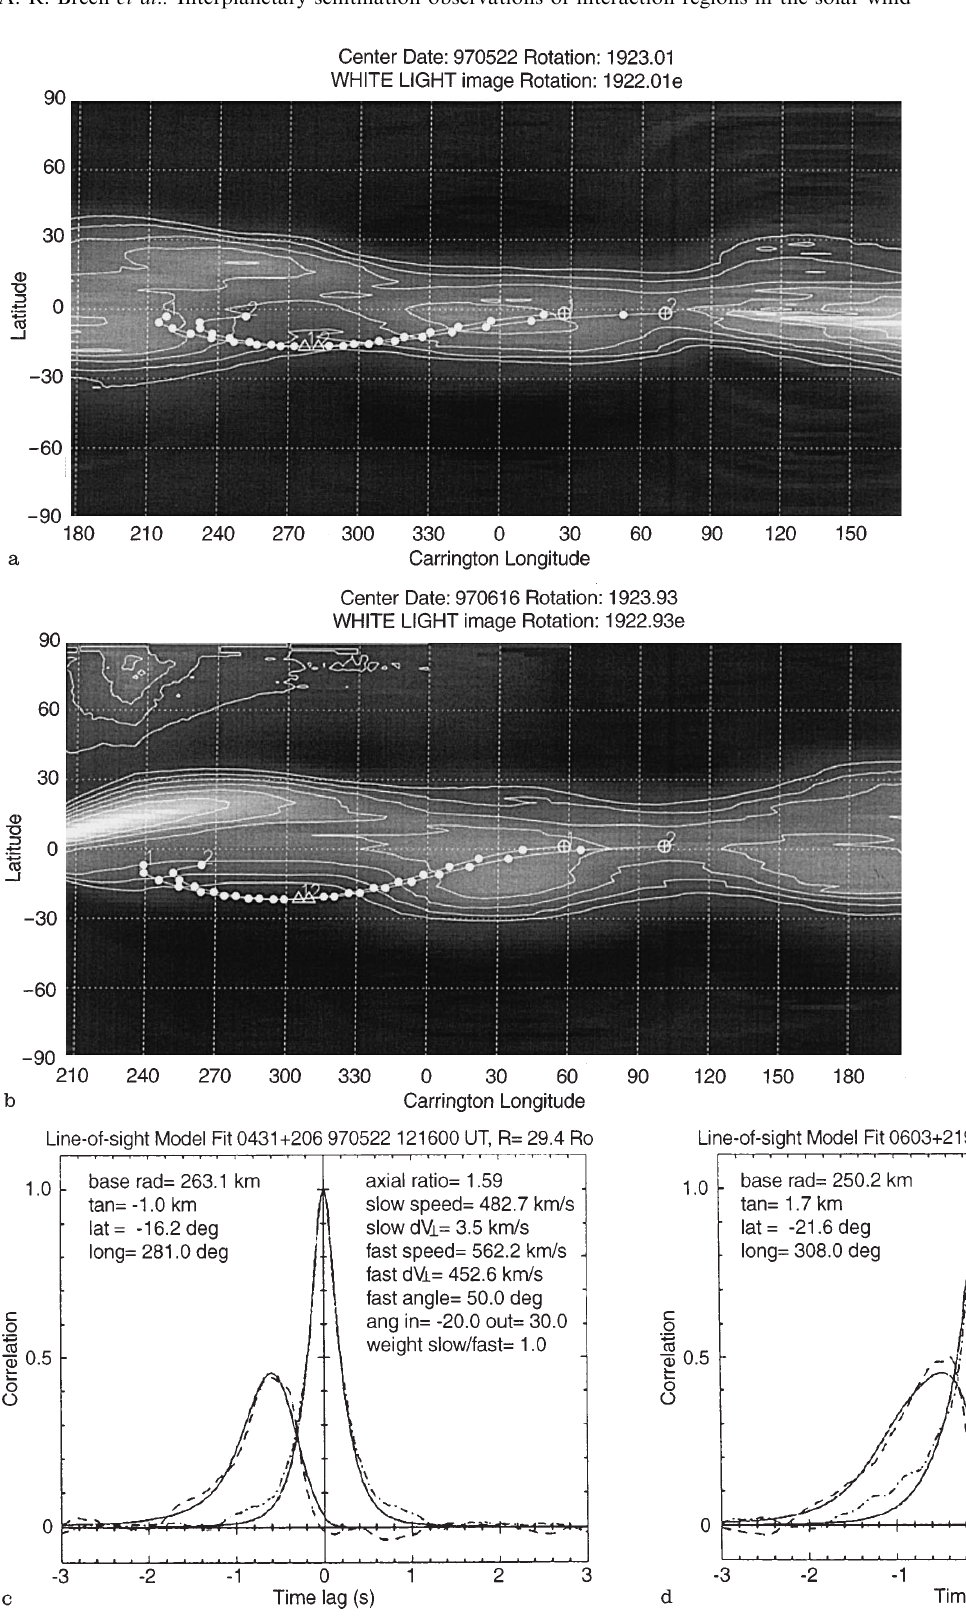
1.7 R withassumedvelocitiesof750 km s ) 1 (line1)and325kms ) 1 (line 2). c Correlationfunctionsfortheobservationof0431+206on22May 1997 shown in part a . d Correlation functions for the observation of 0603+219on16 th June1997showninpart b .Theobservedcorrelation functions in c and d are shown as broken lines and the results of the model fit as solid